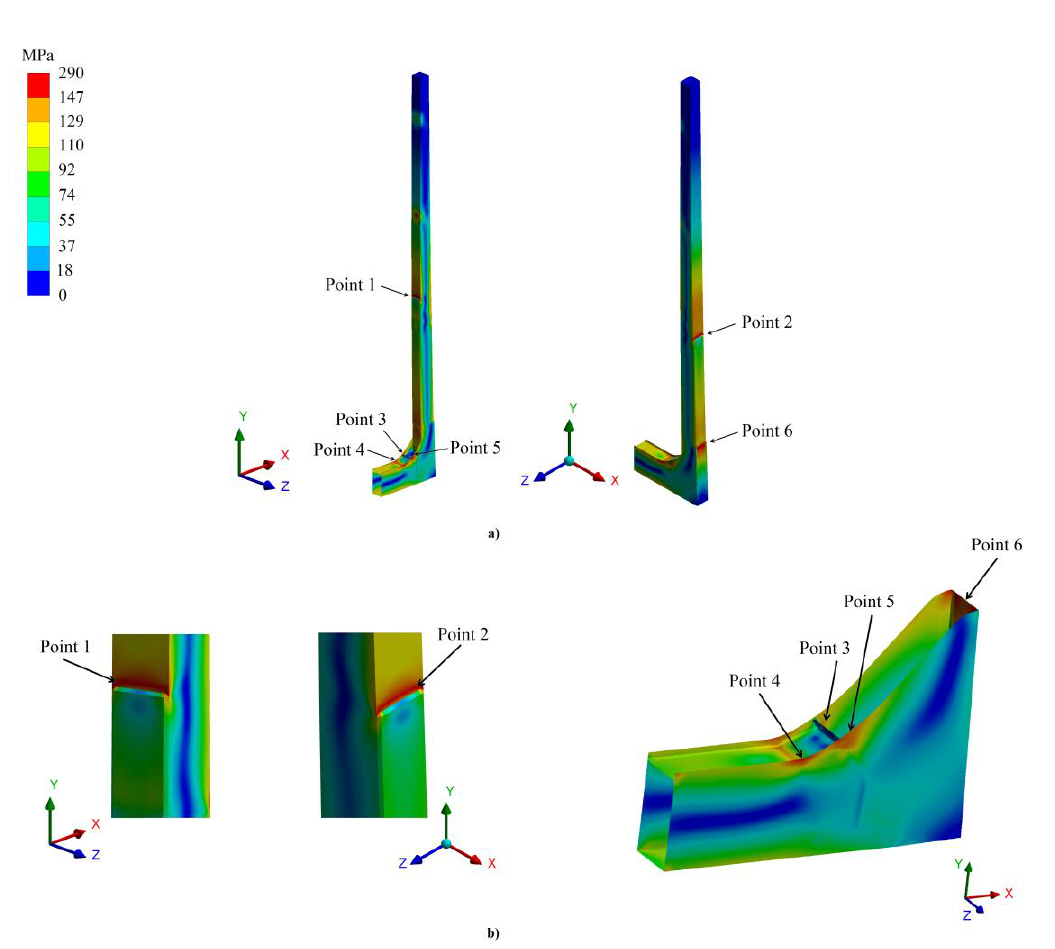
Figure 8. Von Mises stress distribution and stress concentration points under static load: ( a ) general views; ( b ) detailed views.